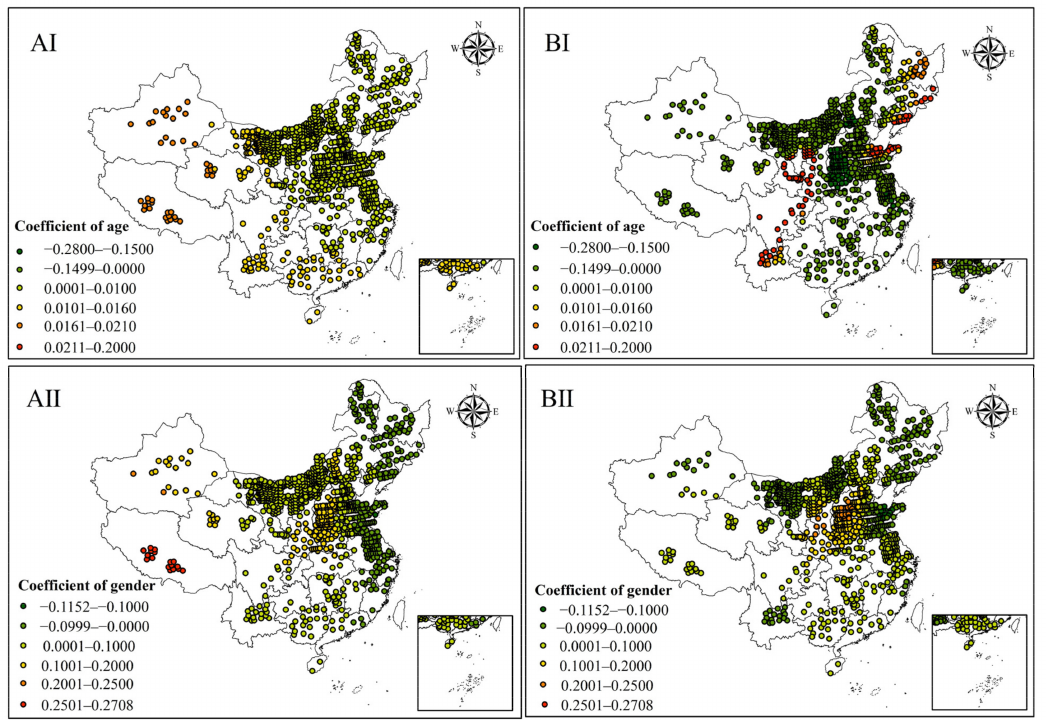
Figure 5. The effects of age ( above ) and gender ( below ) in describing WTPEP before ( left ) and during ( right ) COVID-19 based on MGWR models.